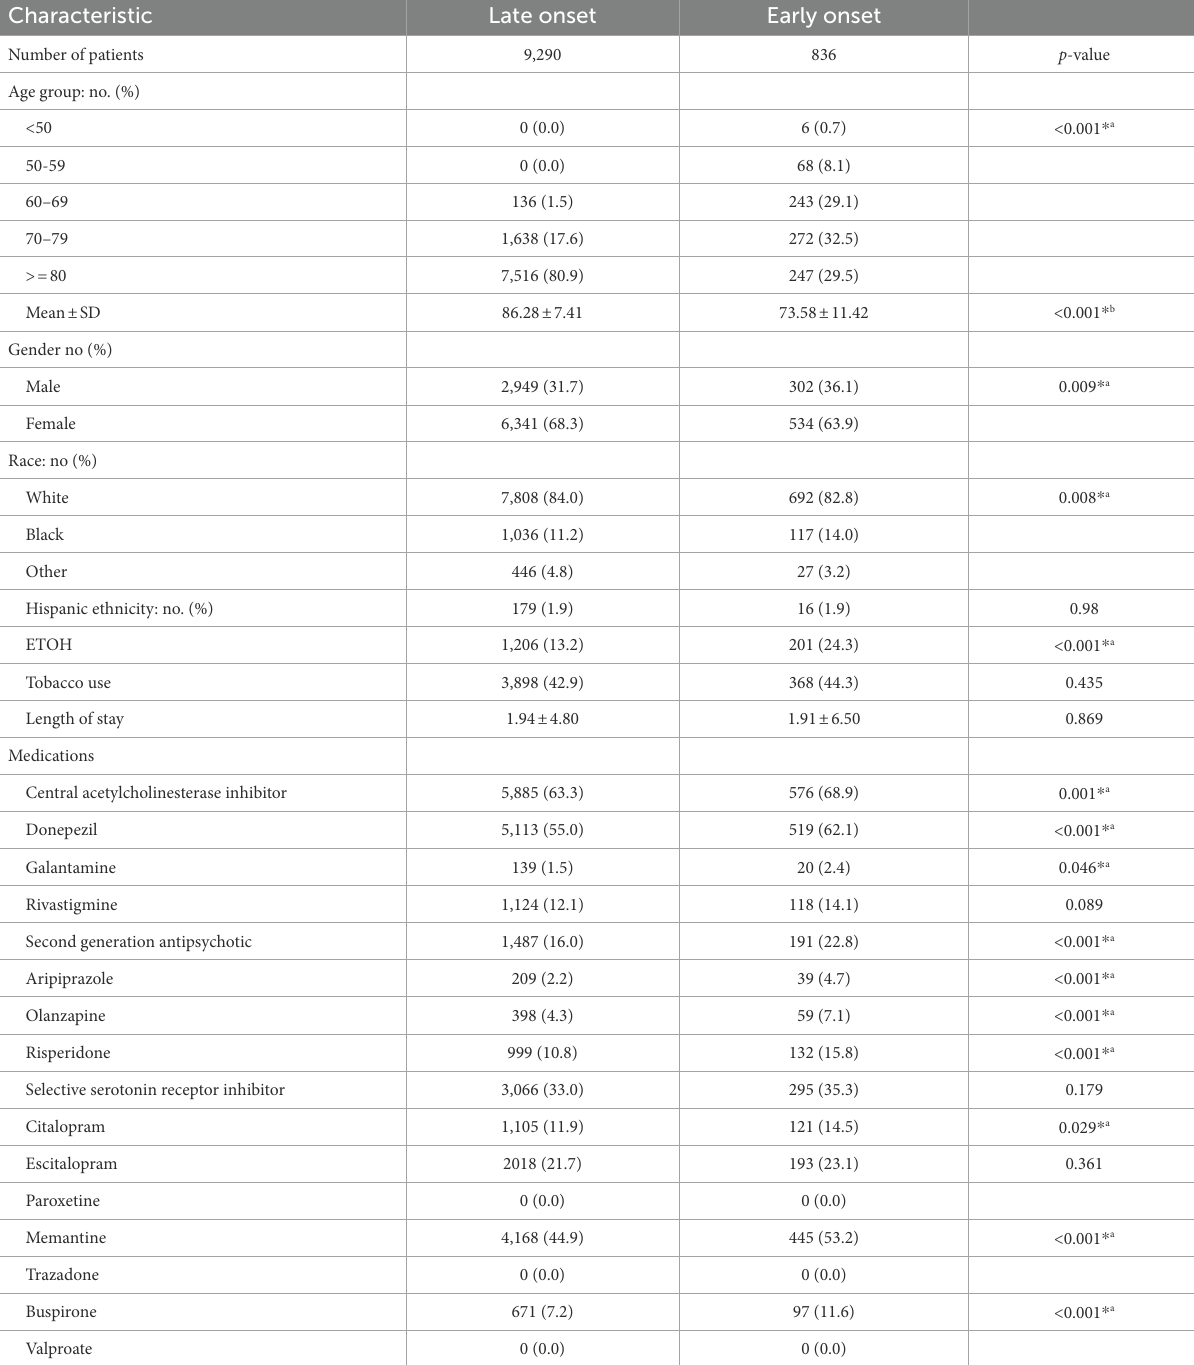
TABLE 1 Demographic and pharmacological characteristics of early-onset and late-onset Alzheimer’s disease patients.